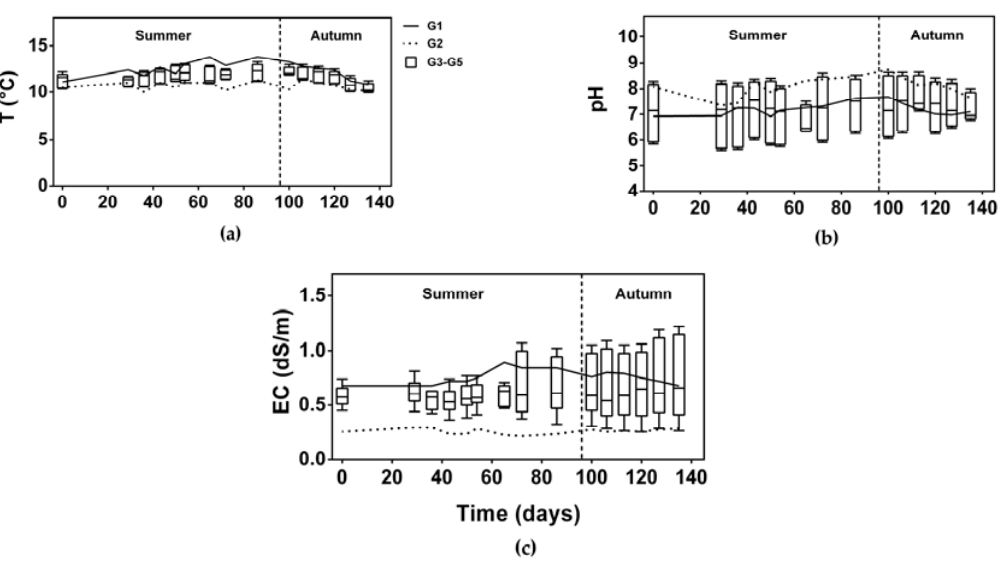
Figure 5. Water quality indicators in groundwater sampling wells (G1, road control; G2, residential control; and G3 to G5, study wells) for the monitoring performed from summer to autumn 2013: ( a ) temperature (T); ( b ) pH and ( c ) electrical conductivity (EC). Solid and dotted lines represent mean values for G1 and G2, respectively. Boxplots show the lower, median, and upper quartiles for G3–G5, with whiskers extending to the most extreme data point.